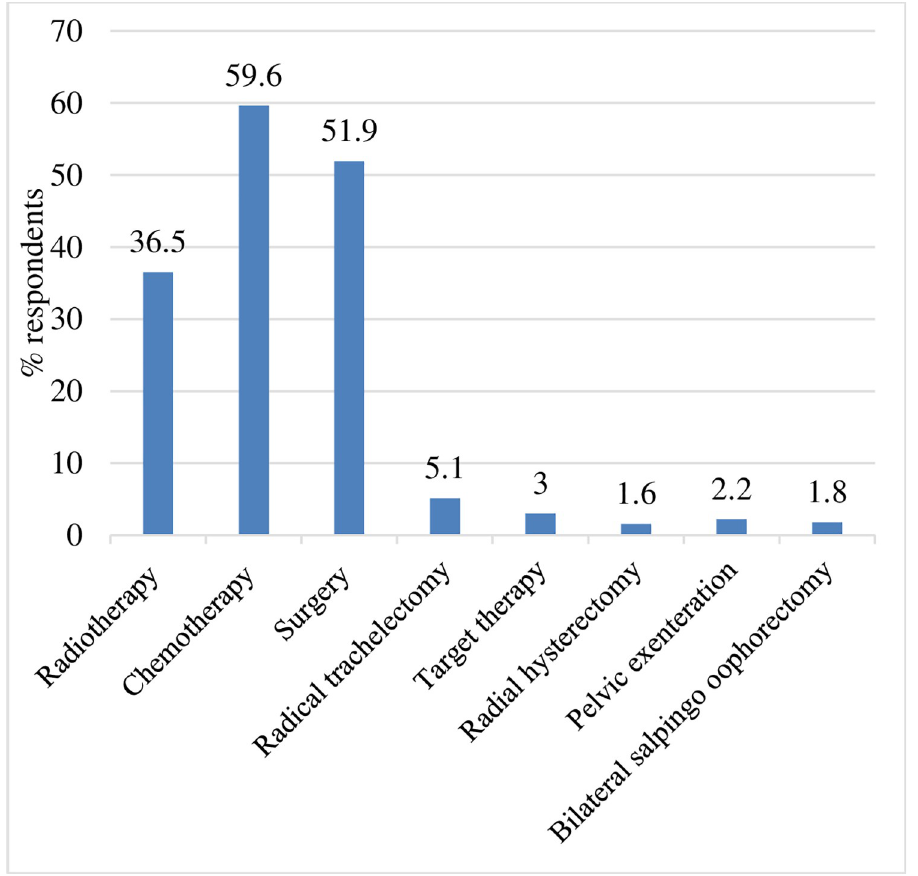
Fig 1. Participants knowledge about cervical cancer